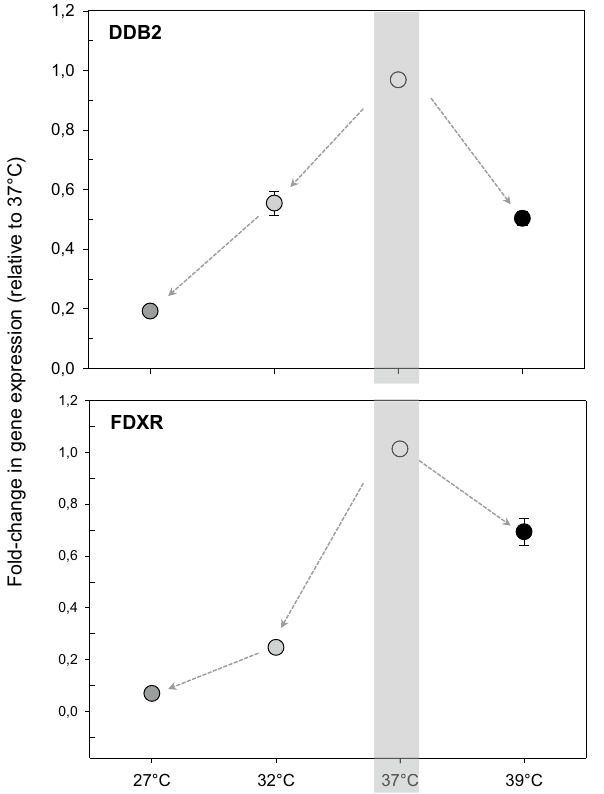
Figure 6. Changes in differential gene expression (DEG) of DDB2 (upper graph) and FDXR (lower graph) relative to 37° C (calibrator) were examined at a range of temperatures between 27 and 39 °C with an additional 3 h incubation time at corresponding temperatures. Symbols are average gene expression fold changes and error bars are SEM (standard error of the mean) from two independent experiments on two blood samples with two technical replicates (total n = 8) (graph created using SigmaPlot Version 14.0, http:// www. systa tsoft ware.